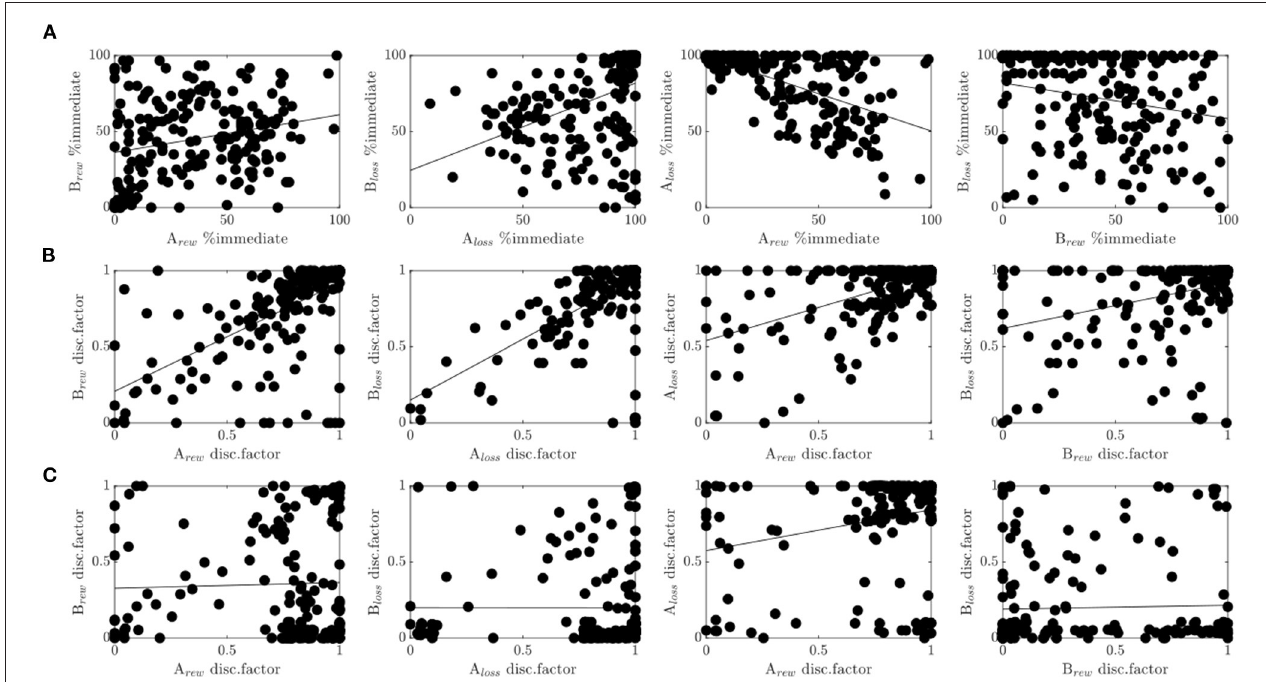
FIGURE 5 | Cross-experimental results. (A) Correlations of the percentage of immediate choices between run A and run B for the reward condition (1st plot), and the loss condition (2nd plot), and between reward and loss conditions within run A (3rd plot), and run B (4th plot). (B) Same as in (A) only with the discount factor evaluated at delay D = 30 for the hyperboloid model. (C) Same as in (B) for the hyperbolic model.